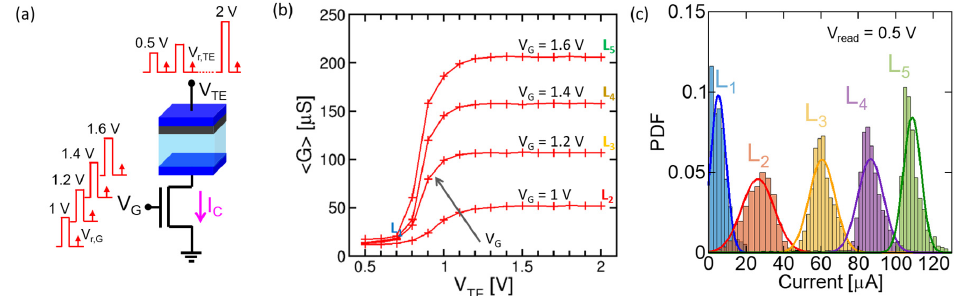
Figure 6. Program and verify algorithm. ( a ) Conceptual schematic of ISPVA program and verify algorithm. ( b ) Mean conductance as a function of set voltage V TE for multiple values of the gate voltage V G . ( c ) Probability density function (PDF) of programmed conductance levels. Reprinted from